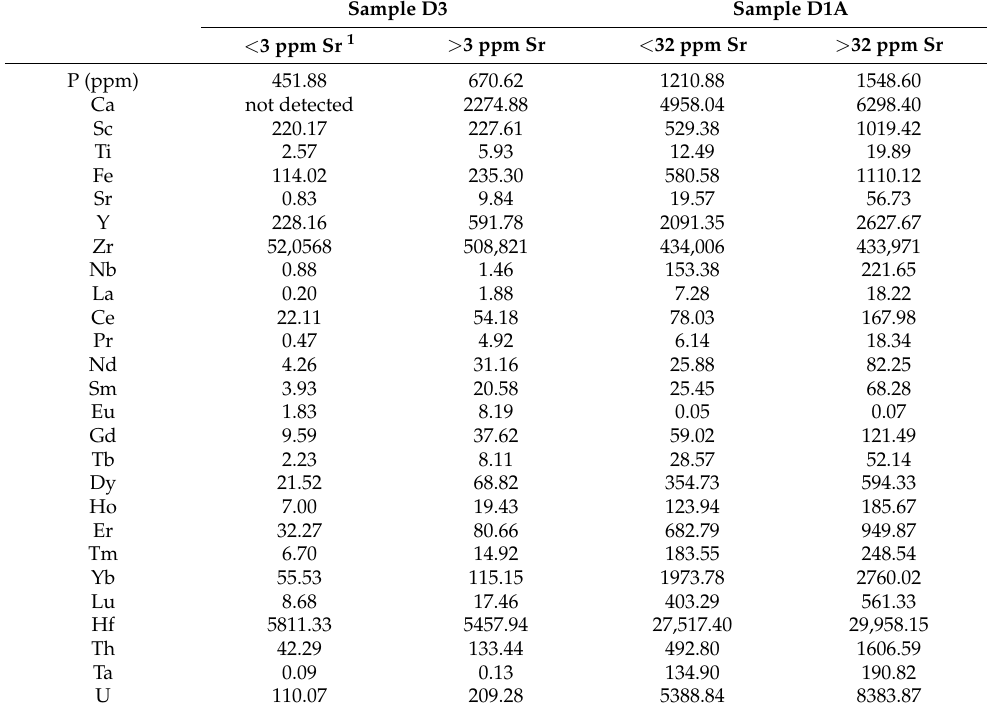
Table 3. General chemical composition of zircon grains (median values).